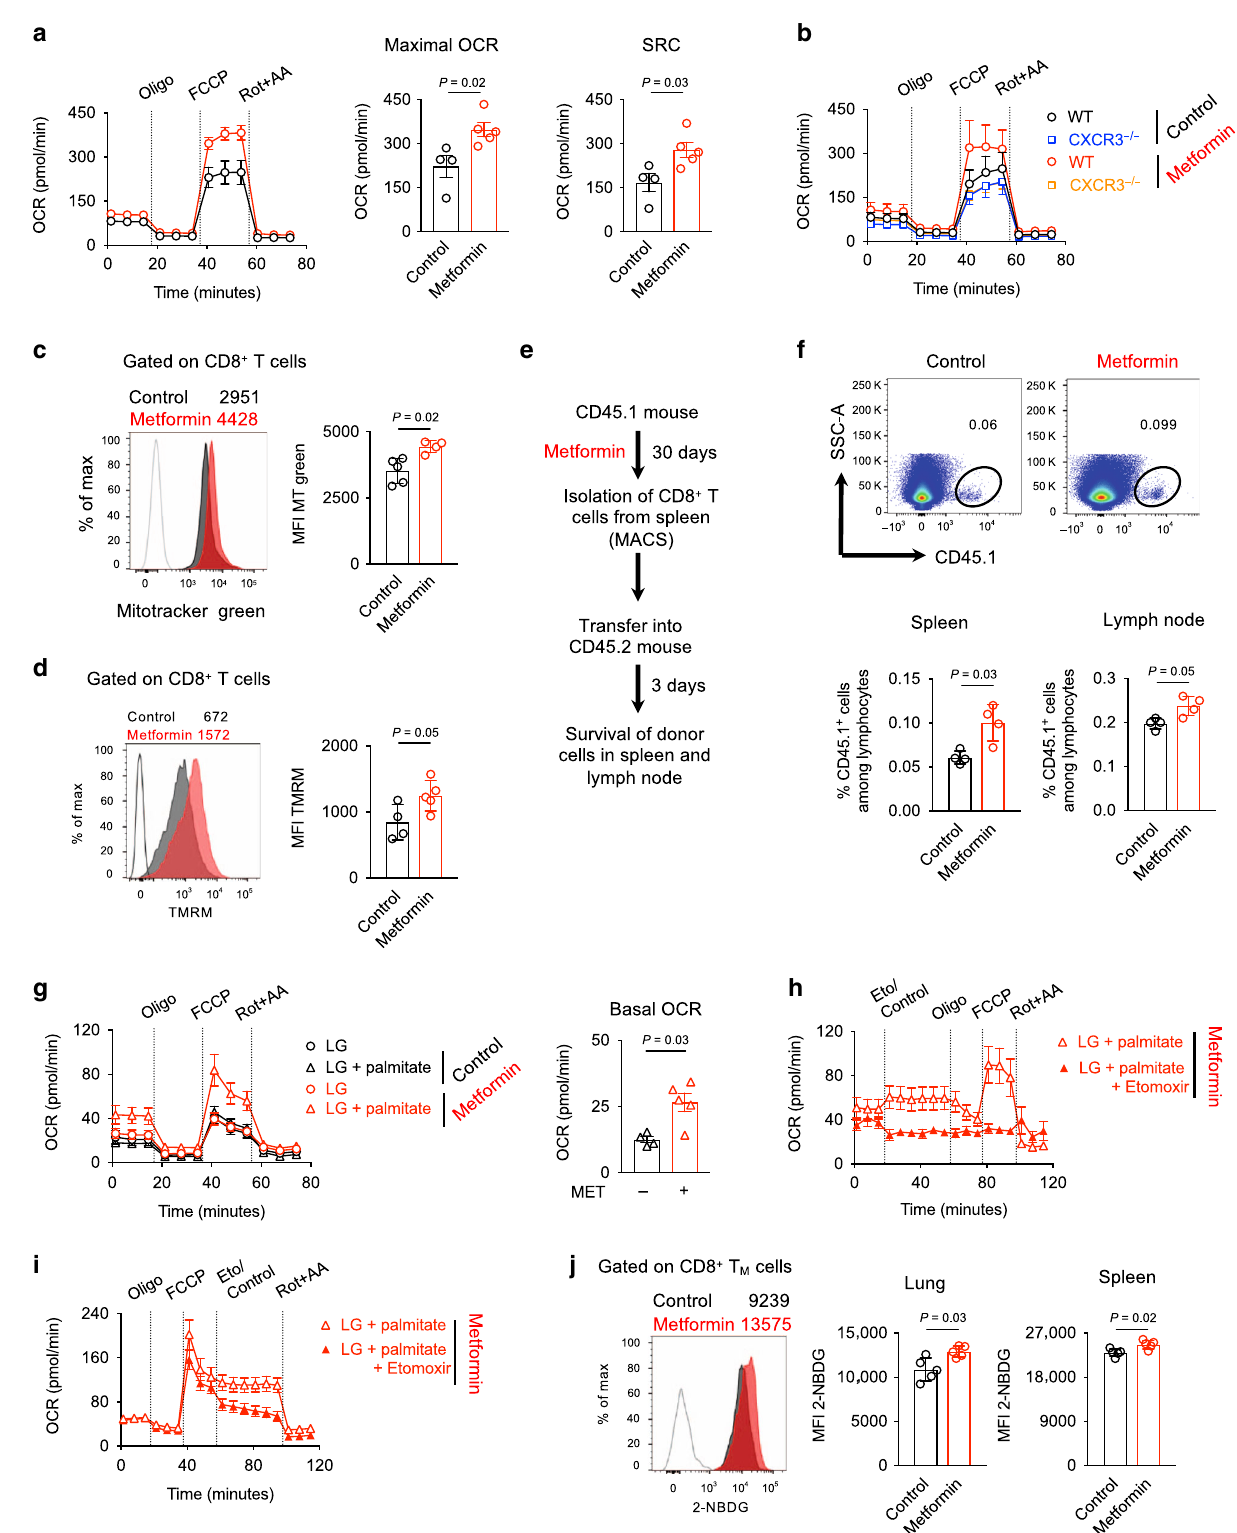
cells from metformin-treated mice (Supplementary Fig. 5c), indicating minimal effect of metformin on the metabolic reprogramming of those cells. Together, our data suggested that glucose fuels mitochondrial FAO, which might be responsible for the induction of OXPHOS in metformin-educated CD8 + T